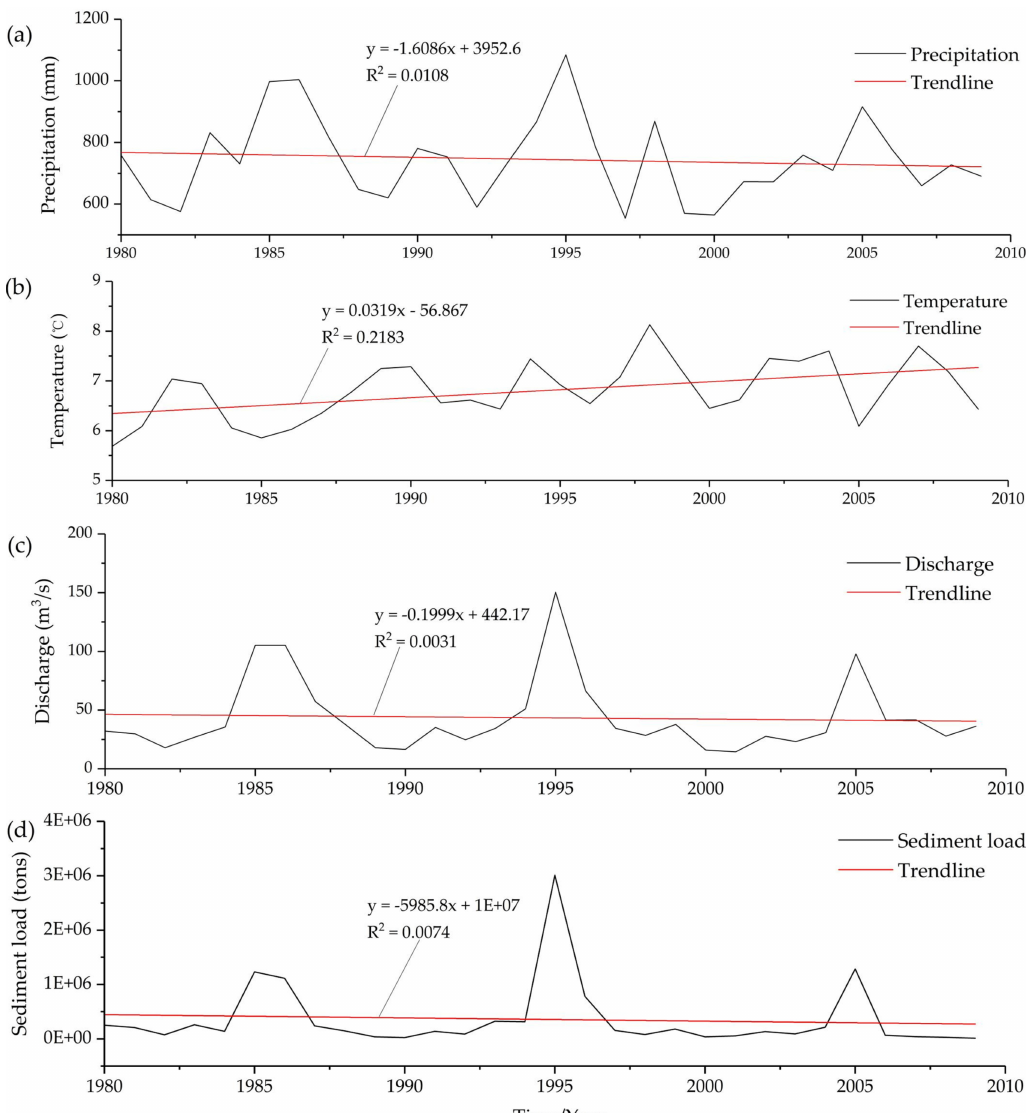
Figure 2. Meteorological change and hydrological change in the HRB at the annual scale: ( a ) change trend of precipitation; ( b ) change trend of temperature; ( c ) change trend of discharge; ( d ) change trend of sediment load. Table 5. M-K test results for meteorological and hydrological variables during 1980–2009.